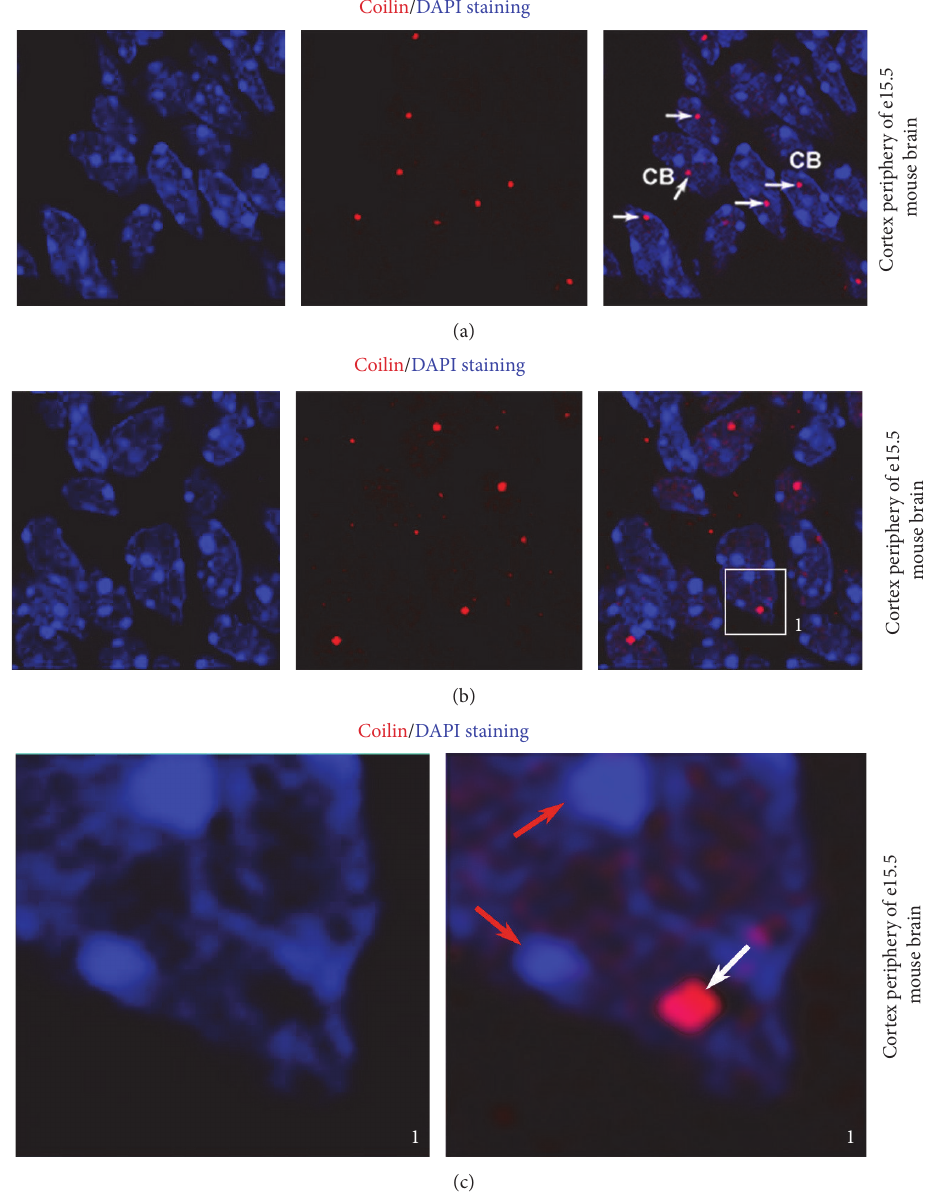
Figure 1: Formation of Cajal bodies (CBs) in the cortex periphery of e15.5 mouse embryonic brains (a–c). CBs were visualized with Alexa 594 fluorescence (red), and DAPI (4 󸀠 ,6-diamidino-2-phenylindole) was used as a counterstain (blue). Arrows in (a) show individual CBs and the frame in (b) shows a selected region in the cell nucleus magnified in (c). Red arrows in (c) indicate the clusters of centromeric heterochromatin (chromocenters) and white arrows show the selected